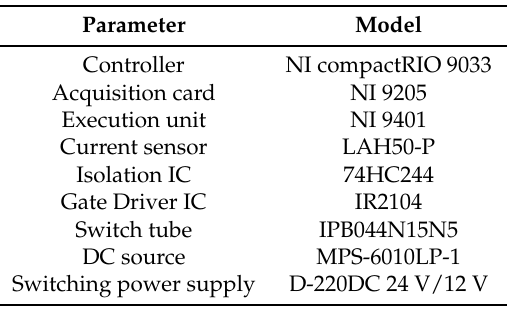
Table 2. Experimental platform design parameters.